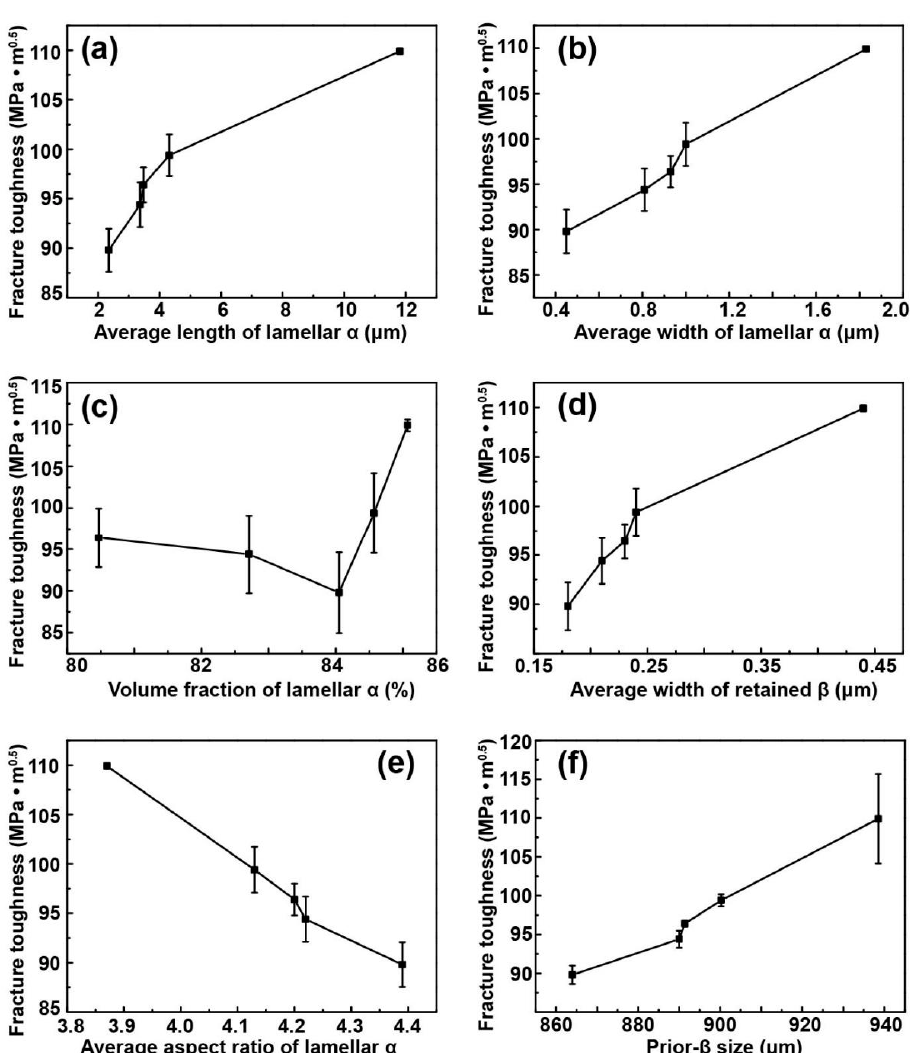
Figure 16. Variations in fracture toughness and microstructural features. ( a ) Average length, ( b ) average width, and ( c ) volume fraction of lamellar α ; ( d ) average width of retained β ; ( e ) average aspect ratio of lamellar α ; and ( f ) prior- β size.